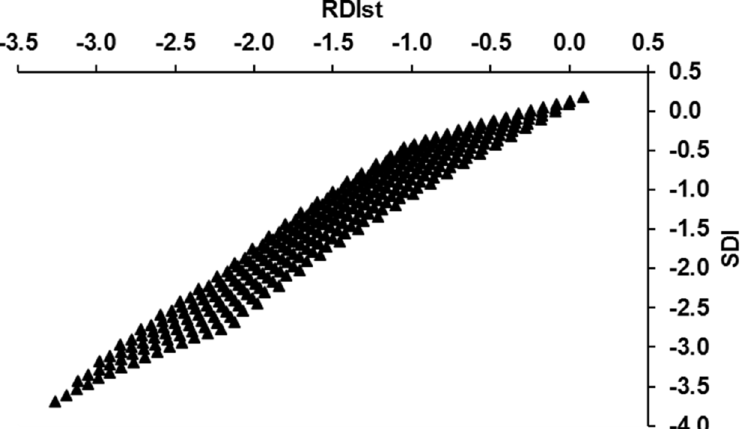
Figure 7. Relationship between the anticipated standardised Reconnaissance Drought Index ( RDI st ) and the Streamflow Drought Index ( SDI ) for the upper Diyala example